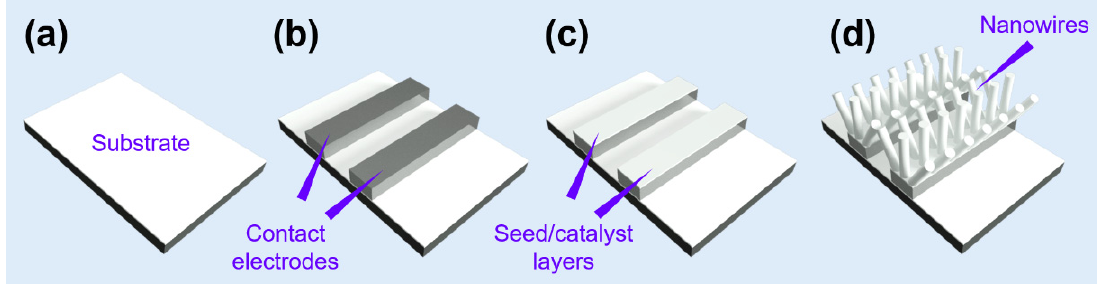
Figure 16. A typical method for making bridging metal–oxide nanowires device: ( a ) substrate; ( b ) bottom electrode deposition; ( c ) seed/catalyst layer deposition; and ( d ) in situ growth of metal–oxide nanowire on electrodes.